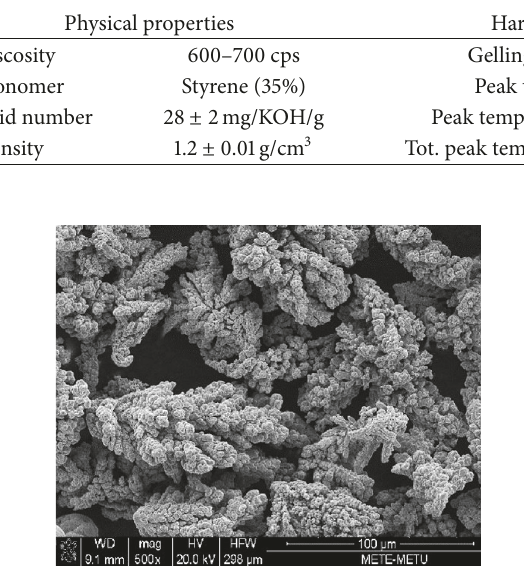
Figure 1: Dendrite-shape copper particle ( × 500).